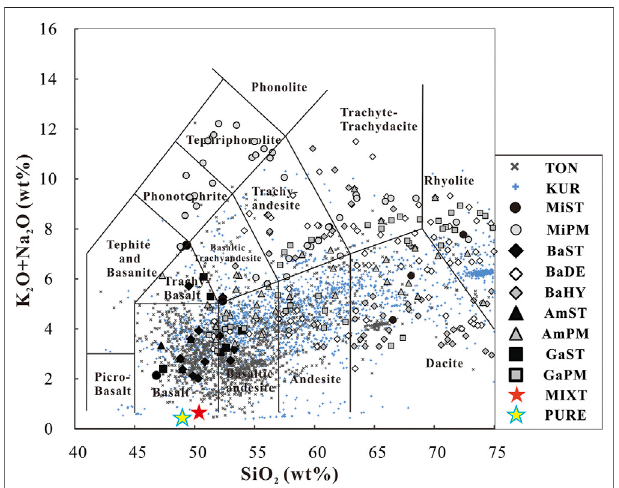
FIGURE 1 | Total alkali versus silica (TAS) variation diagram of basic rocks and their product-melts in partial melting experiments. This fi gure is modi fi ed from Figure 2 in Zang et al. (2020), Classi fi cation and nomenclature of TAS diagram follow Maitre (1989). BaST, starting material of basalts; BaDE, melts generate in basalts ’ partial melting experiments; BaHY, melts generate in partial melting of hydrous basalt (Beard and Lofgren 1991; Qian and Hermann 2013; Rapp and Watson 1995; Rapp, et al., 1991; Rushmer 1991; Sisson, et al., 2005; Takahahshi, et al., 1998; Xiong, et al., 2005, 2006; Yaxley and Green 1998). AmST, starting material of amphibolites; AmPM, meltsgeneratedinpartialmeltingexperimentsonamphibolites(SenandDunn 1994; Rapp and Watson 1995). GaST, starting material of gabbros; GaPM, melts generate in partial melting experiments on gabbros (Koepke, et al., 2004; Sisson,et al., 2005). MiST, starting material of mixtures (basalt + sediment or mélange); MiPM, melts from partial melting experiments on these mixtures (Cruz-Uribe et al., 2018; Zang et al., 2020). PURE, pure starting material used in this paper, 18TH-02 (garnet plagioamphibolite, as a representative of metamorphic oceanic crust), MIXT, mixture starting material used in this paper, 90wt% 18TH-02 + 10wt% 18 TH-07 (plagioclase slate, as a representative of metamorphic terrigenous sediment), TON, magmatic rocks located at Tonga island arc; KUR, magmatic rocks located at the Kuril Islands,dataonTONandKURarefromtheGEOROCwebsite(http://georoc. mpch-mainz.gwdg.de/georoc/).